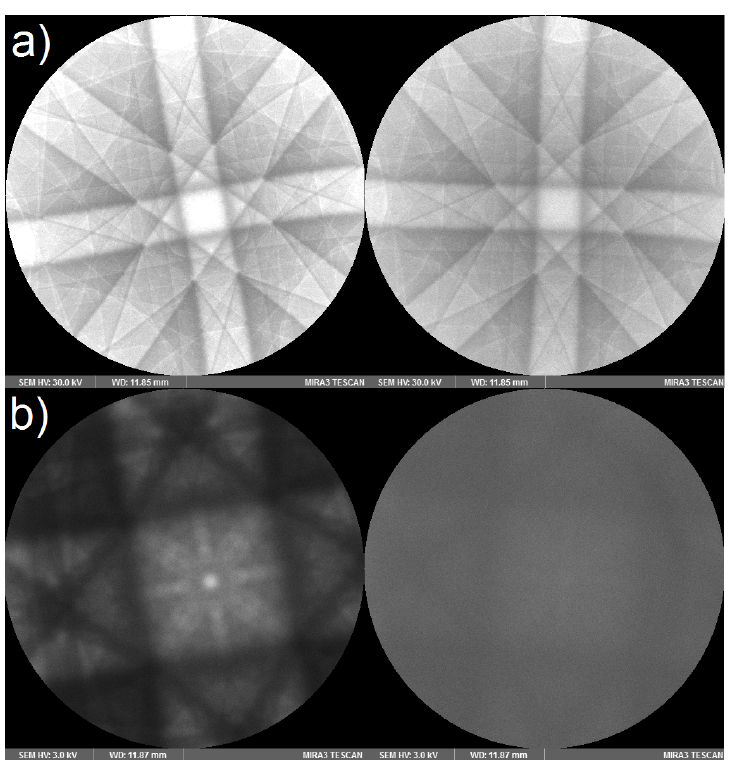
Figure 3 : Electron channeling pattern at accelerating voltage of a) 30 kV and b) 3 kV: left: untreated sample Si (100); right: 30 min oxygen plasma treated sample Si (100).